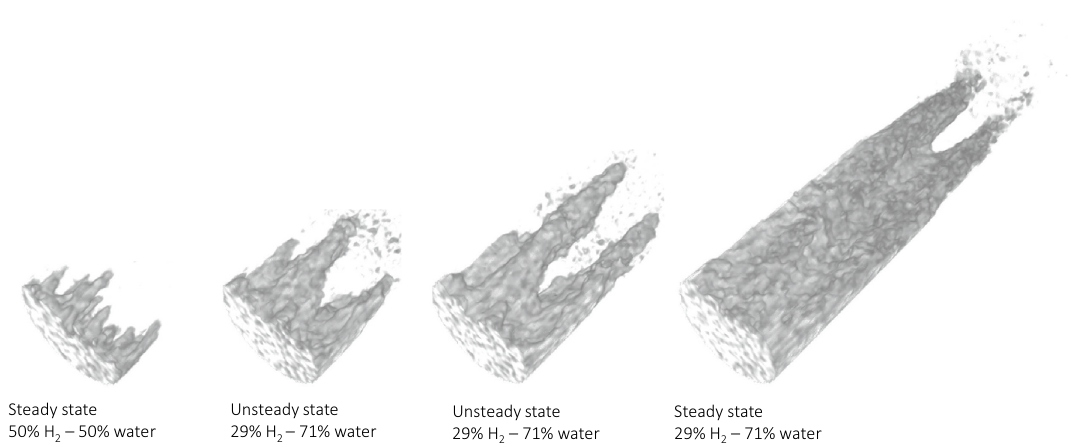
Figure 5. Steady-state high water saturation fingers evolving into a high water saturation channel during Imbibition